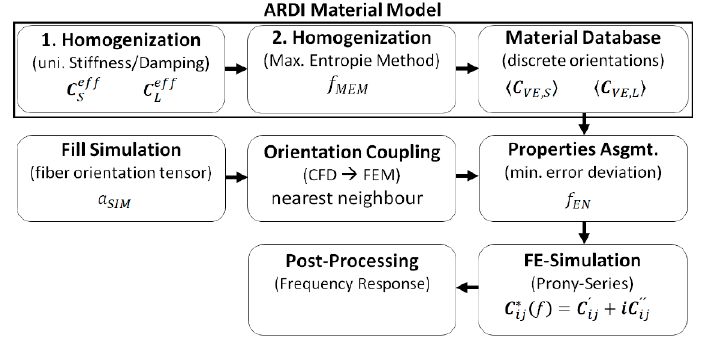
Figure 1. Concept for embedding the Arbitrary-Reconsidered-Double-Inclusion (ARDI) material model in a simulation routine.